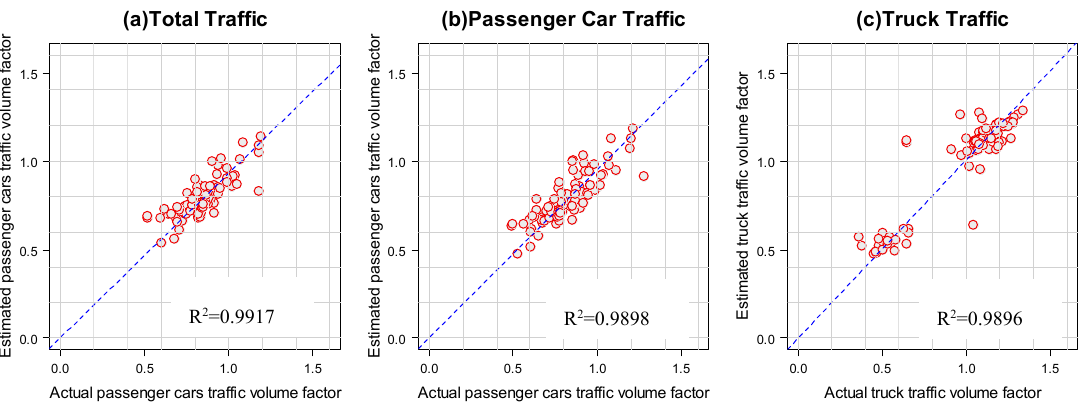
Figure 17. The accuracy of temporal transferability for naive regression model at Red Deer Highway 2.